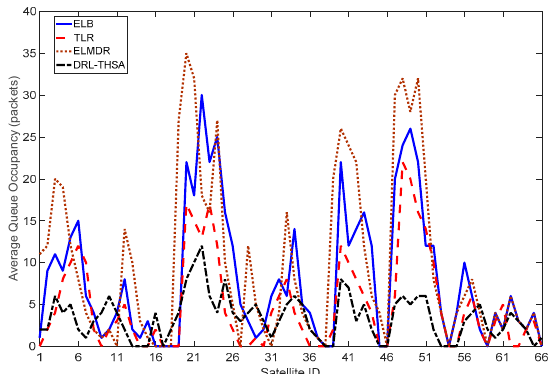
Figure 12. The average queue occupancy for each satellite.